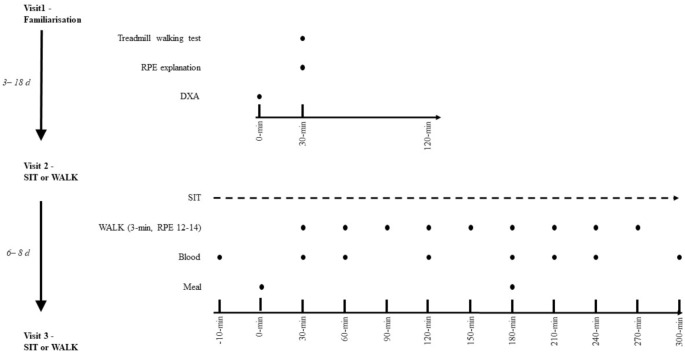
Experimental schematic. SIT, uninterrupted sitting; WALK, breaking up sitting with walking. Both conditions are identical except in SIT, no walking breaks occurred.